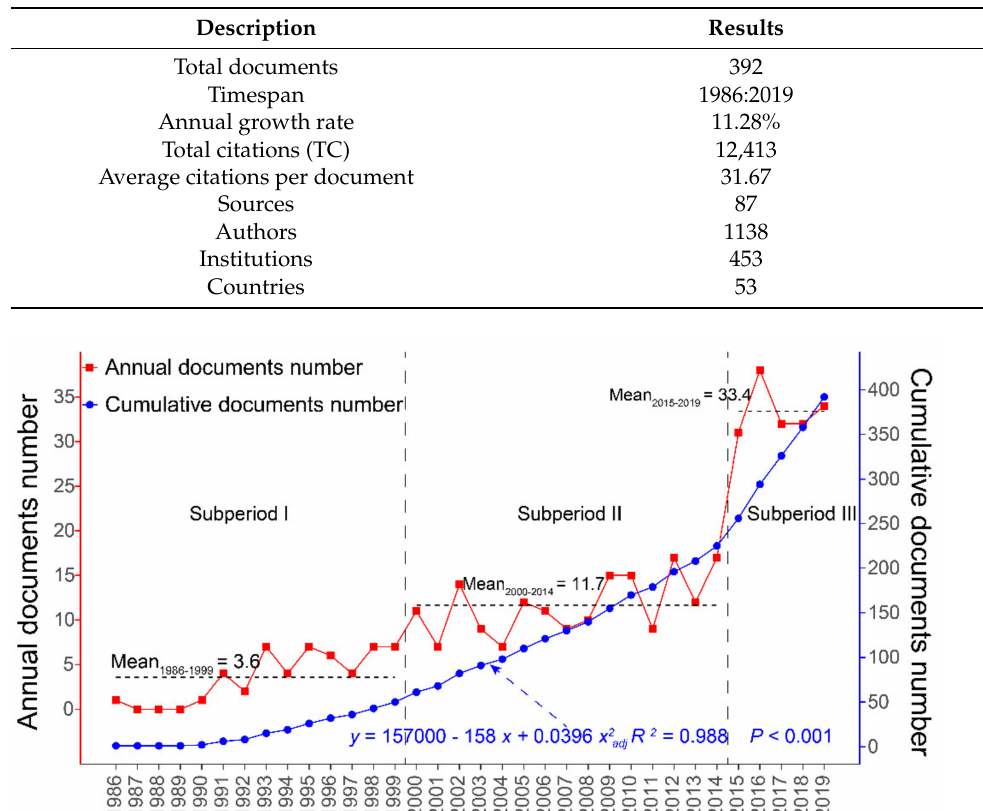
Figure 2. The publication output of IHS between 1986 and 2019. The transverse dashed lines present the mean values of the number of documents per year in each